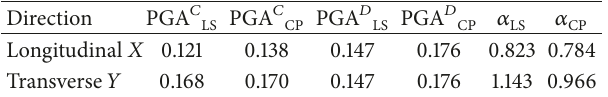
Table 4: Capacity and demand peak ground acceleration and corresponding risk